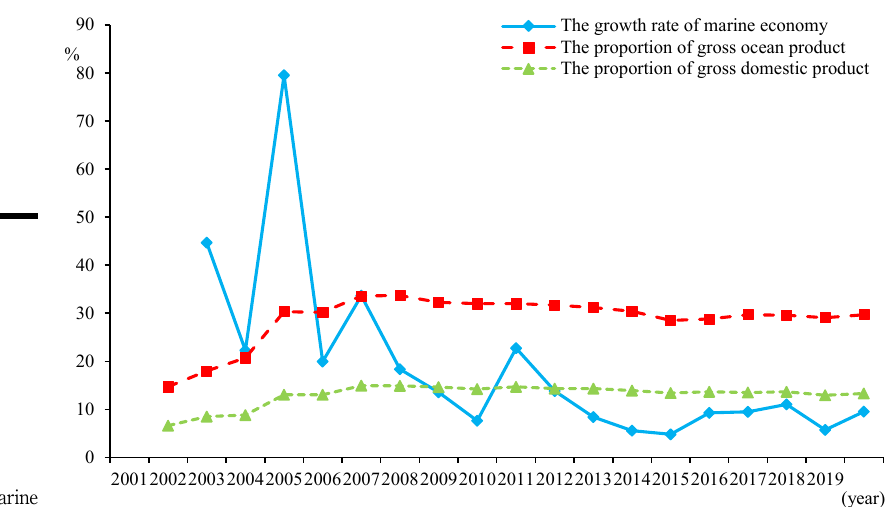
Figure 6. Development of